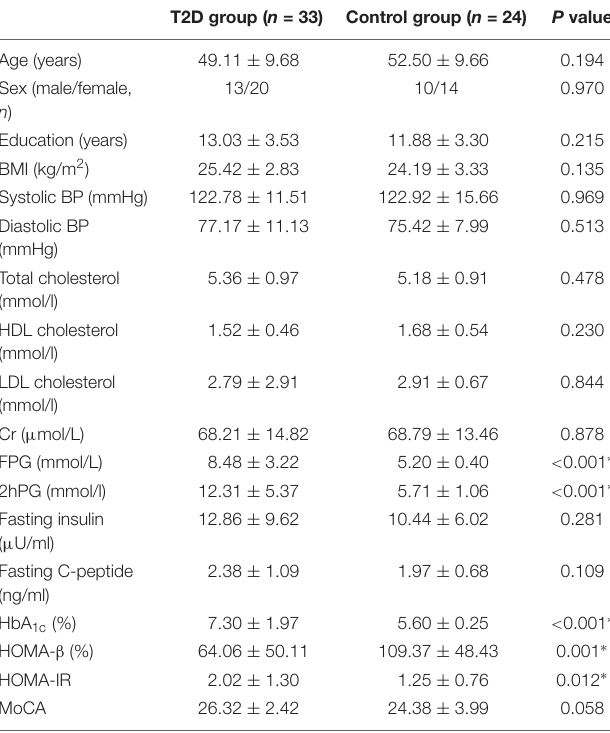
TABLE 1 | Demographic and clinical characteristics of all subjects.